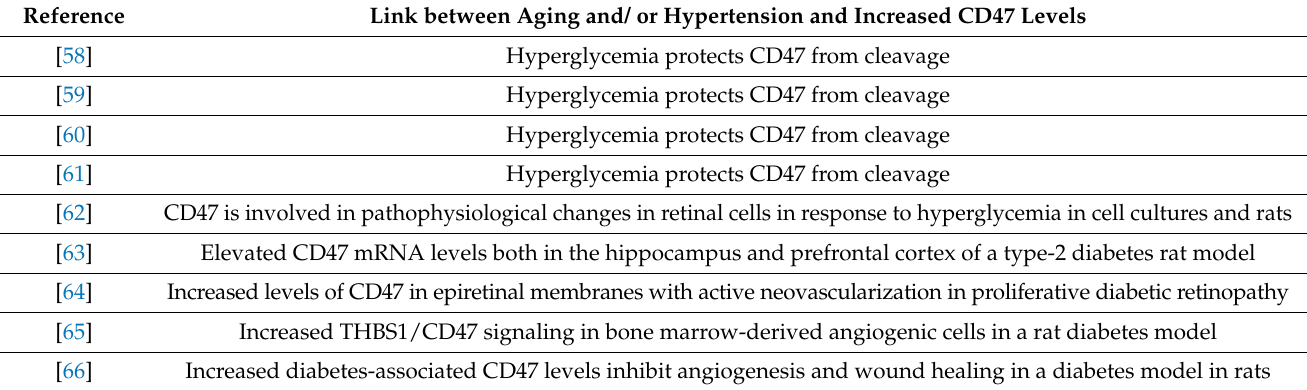
Table 2. Evidence supporting a link between diabetes and increased CD47